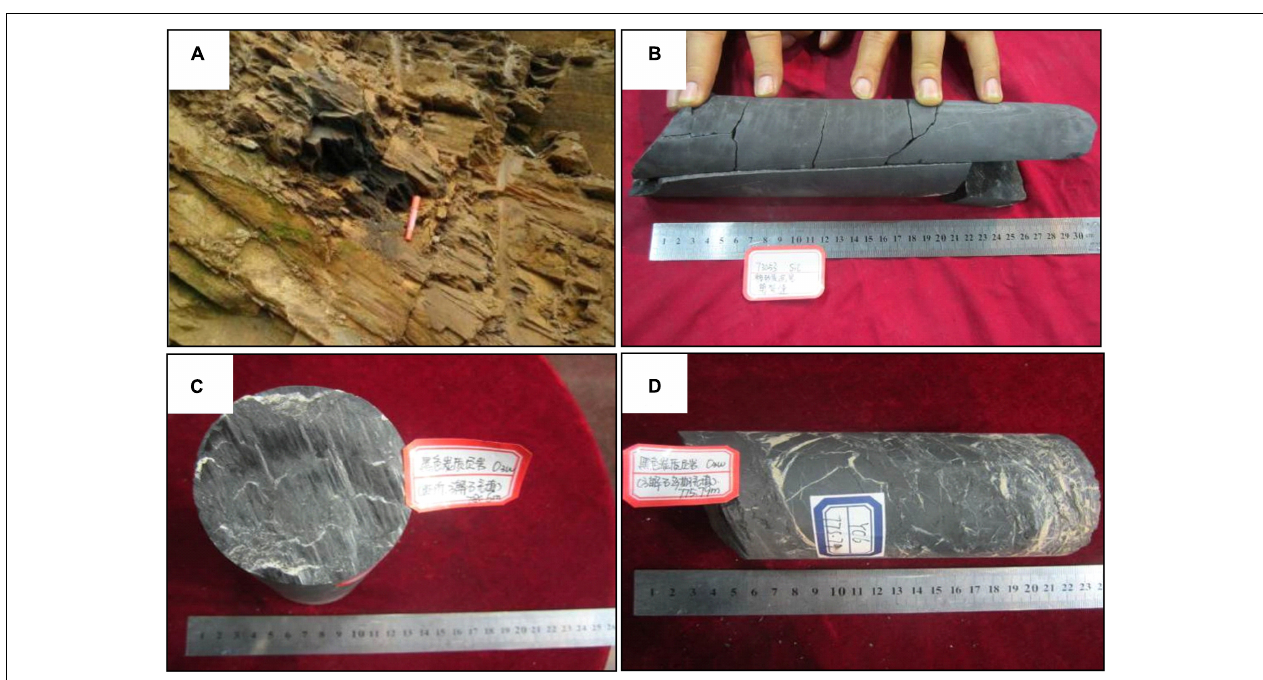
FIGURE 5 | Distribution characteristics of fractures in field section and drilling cores. (A) Wufeng–Longmaxi Formation structural fractures in the Majiaao section of Xiushan; (B) multi-stage structural fractures in the lower part of the Wufeng–Longmaxi Formation, Yucan 4 well; (C,D) attachment and detachment zones in the lower part of the Wufeng–Longmaxi Formation scratches, Yucan 6